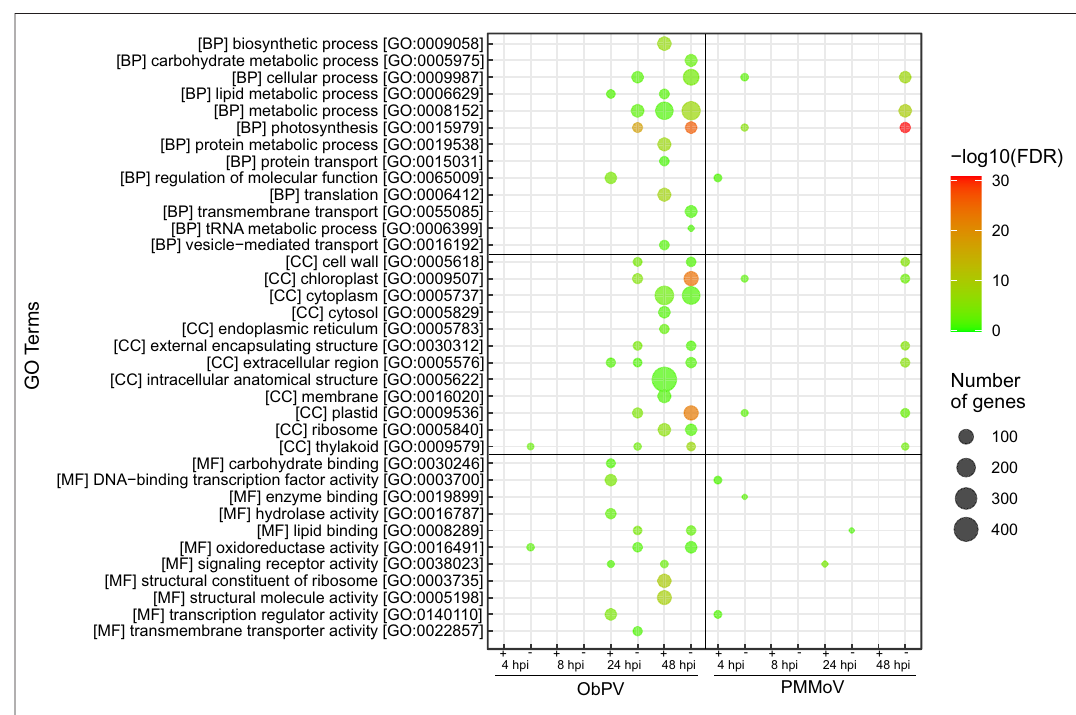
Figure 3. Gene Ontology (GO) classification of differentially expressed genes (DEGs) in pepper leaves inoculated with Obuda pepper virus (ObPV) and Pepper mild mottle virus (PMMoV) at 4, 8, 24 and 48 h post- inoculation (hpi). The number of DEGs in the various pathways is indicated by the size of colored circles, while the circle colors represent the statistical significance of gene enrichment (False Discovery Rate,